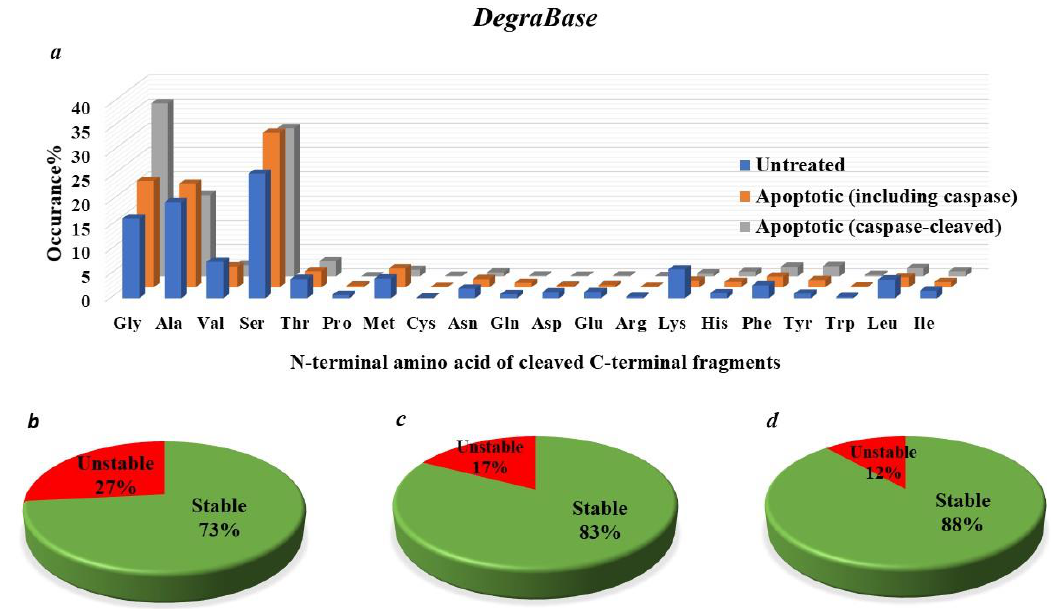
Figure 5. Distinct grouping of proteolytic C-terminal fragments based on bearing different N-terminal amino acid residues within the database Degrabase and their occurrence % as indicated ( a ); ( b ) Quantification of % of occurrence of destabilizing and stabilizing fragments generated by basal proteolytic processing (un-induced cells) based on their theoretical half-lives; ( c ) Quantification of % of occurrence of destabilizing and stabilizing fragments generated during apoptotic induction (including caspases cleavage) based on their theoretical half-lives; ( d ) Quantification of % of occurrence of destabilizing and stabilizing fragments generated by caspases-mediated cleavage based on their theoretical half-lives.